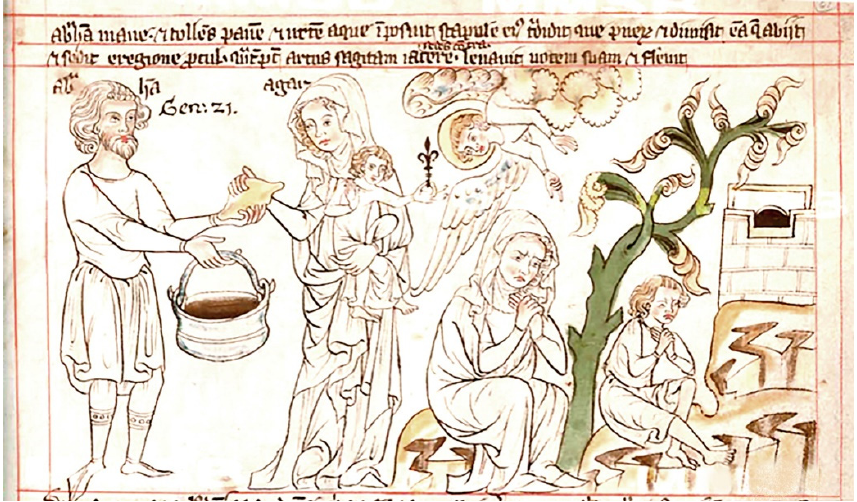
Figure 3. Pamplona Bible I , 1197. Amiens, Bibliothèque municipale, f. 11r.